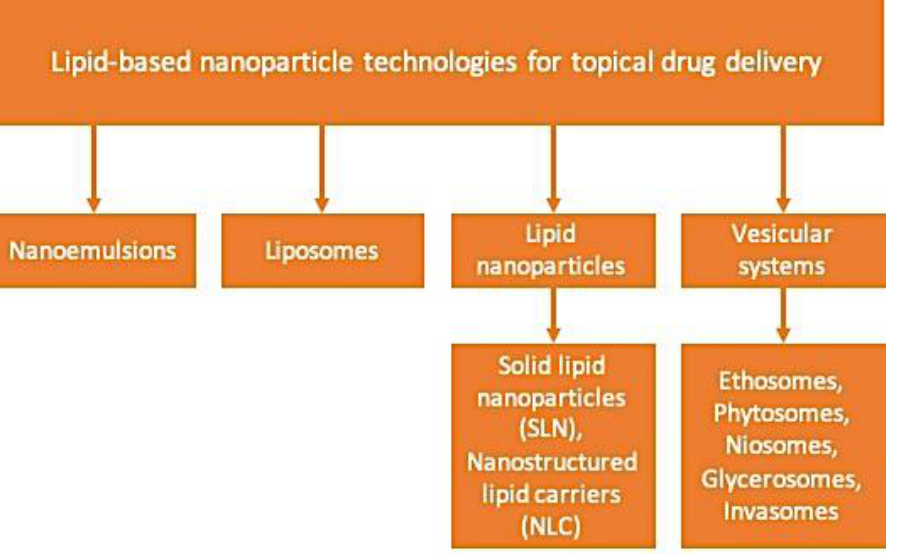
Figure 3. Nanoparticle based on lipids technologies for topical drug delivery.